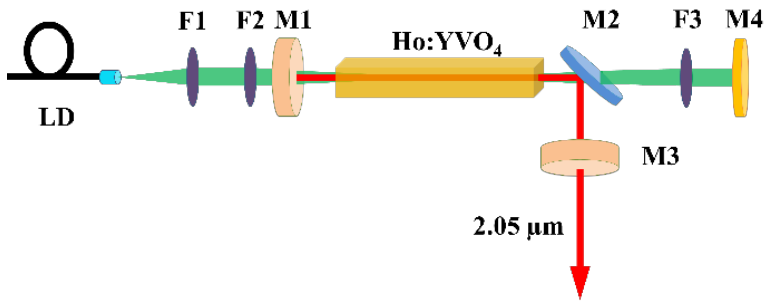
Figure 2. Experimental scheme of the Ho:YVO 4 laser.